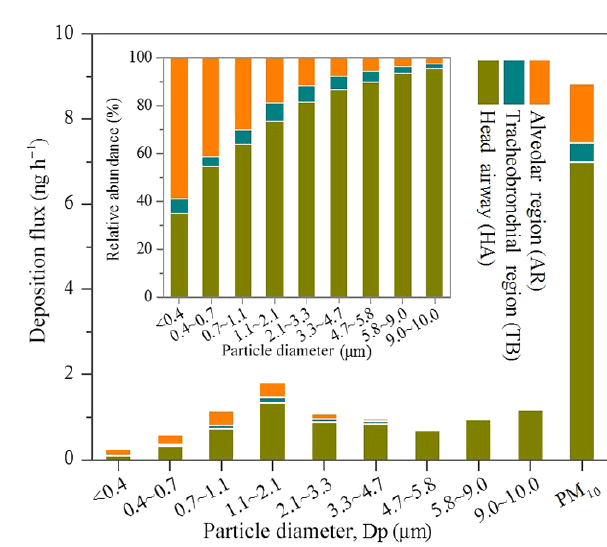
Figure 10. Deposition fluxes (estimated by the ICRP model) and relative abundance of the size-segregated PAHs in the head airway, tracheobronchial region, and alveolar region in the human respira- tory